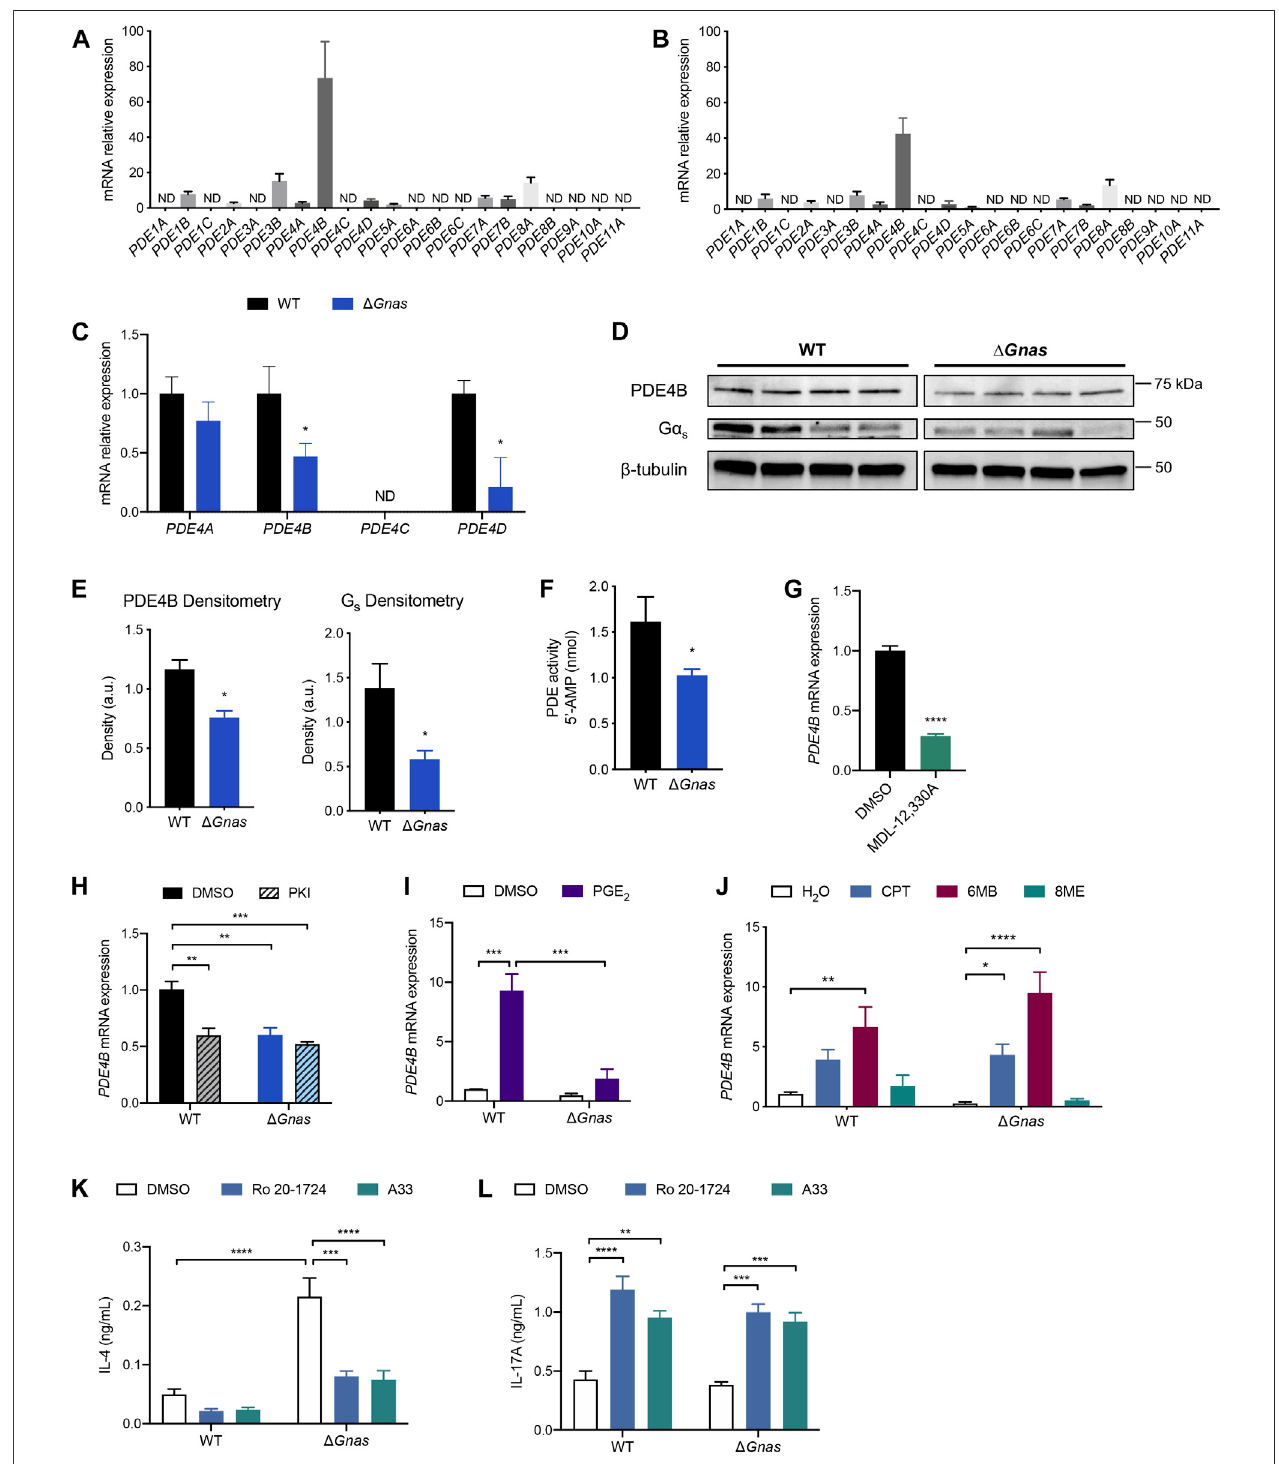
FIGURE 3 | PDE4B expression regulates cAMP levels and PDE4B inhibition decreases Th2 differentiation and increases Th17 differentiation in DCs. (A , B) Expressionpro fi leofPDEmRNAexpression in (A) WTDCs; n =7and (B) Δ Gnas DCs; n =6.ND=notdetected; datanormalized tolowest-expressingdetectablegene. (C) PDE4 isoform fold change in Δ Gnas DCs compared to WT cells; n = 5 – 6. (D) Western blots and (E) densitometry of G α s and PDE4B protein expression in WT and Δ Gnas DCs; n = 4. (F) PDE activity in WT and Δ Gnas DCs; n = 5 – 6. (G) PDE4B expression after treatment of WT DCs with the adenylyl cyclase inhibitor MDL- 12,330A (10 μ M, 16 h); n = 3. (H) PDE4B expression in WT and Δ Gnas DCs treated with a PKA inhibitor (PKI, 10 μ M) for 24 h; n = 4. Data normalized to WT DMSO